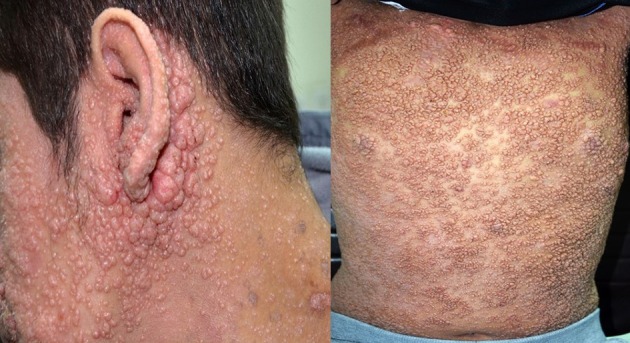
Severe and disseminated molluscum contagiosum in a patient with dedicator of cytokinesis 8 deficiency (DOCK8) deficiency. The patient signed an informed written consent for publication of the images.